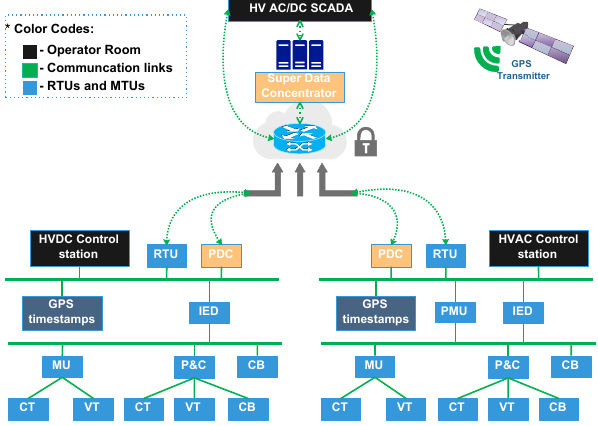
Figure 6. HV AC/DC SCADA: Structure from top to